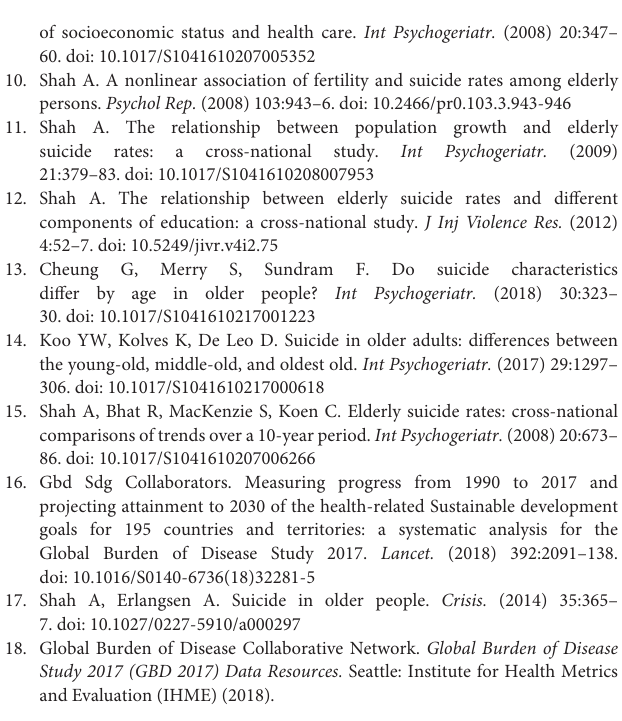
countries and territories. The line represents the mortality rates expected on the basis of SDI alone, with linear model and restricted cubic spline (RCS) smoother which includes 5 knots at the 5th, 27.5th, 50th, 72.5th, and 95th percentiles. Supplementary Figure 3 | Projected percentage changes in mortality rates from suicide for the elderly between 2015 and 2030. Percentage change = 100 × (R 2030 − R 2015 ) / R 2015 , where R 2015 donates mortality rate from suicide for the elderly in 2015 derived from Global Burden of Disease 2017, and R 2030 donates mortality rate from suicide for the elderly in 2030 which was predicted by Autoregressive Integrated Moving Average (ARIMA) model. Blue regions refer to ten countries and territories that are expected to meet the UN Sustainable Development Goals (SDGs) indicator of a one-third reduction, including Turkey, Singapore, China, Croatia, Iraq, Bulgaria, Latvia, Switzerland, Estonia, and Sweden. Supplementary Figure 4 | Projected national mortality rates from suicide for the elderly up to 2030. Black points and solid lines denote suicide mortality rates derived from Global Burden of Disease study 2017. Blue points and solid lines denote projected suicide mortality rates from 2018 to 2030 based on the mean rates from 1990 to 2017 using Autoregressive Integrated Moving Average (ARIMA) model. Blue dashed lines denote 95% confidence intervals for the projected suicide mortality rates, with the lower bounds being forced to 0 for those < 0. Supplementary Figure 5 | Relationship between SDI and elderly suicide mortality rates from 1990 to 2017 for 195 countries and territories fitted by a local polynomial regression. SDI = Socio-demographic Index. Model is weighted by the elderly population. Y axis is shown after the square root transformation. Each hollow point corresponds to the mortality rate for a country or territory in a specific year. For a given location, the gradient colors from light to dark indicate the years from 1990 to 2017. The line represents the mortality rates expected on the basis of SDI, with a local polynomial regression. Supplementary Figure 6 | Relationship of the suicide mortality rates for the elderly with fertility rate (A) , GDP per capital (B) , and secondary school enrollment (C) in 2017. Models are weighted by the elderly population (point size). Y axes are shown after the square root transformation. The black curves represent the mortality rates expected on the basis of each socioeconomic indicator alone, with linear model and restricted cubic spline smoother which includes 5 knots at the 5th, 27.5th, 50th, 72.5th, and 95th percentiles. Each point of a specific color represents one country or